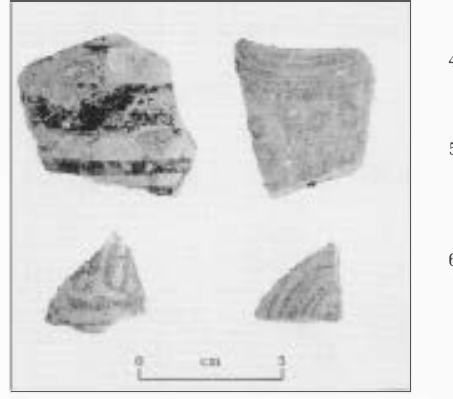
Figure 6 Minoan Neopalatial painted sherds from a surface site in central Kythera.